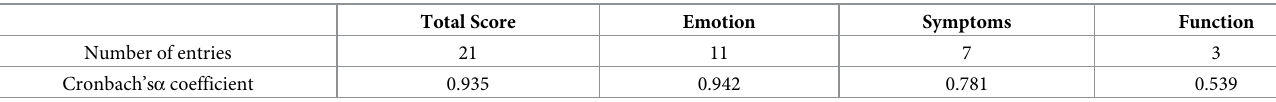
Table 2. Cronbach’s alpha for the RosQol (n = 265).